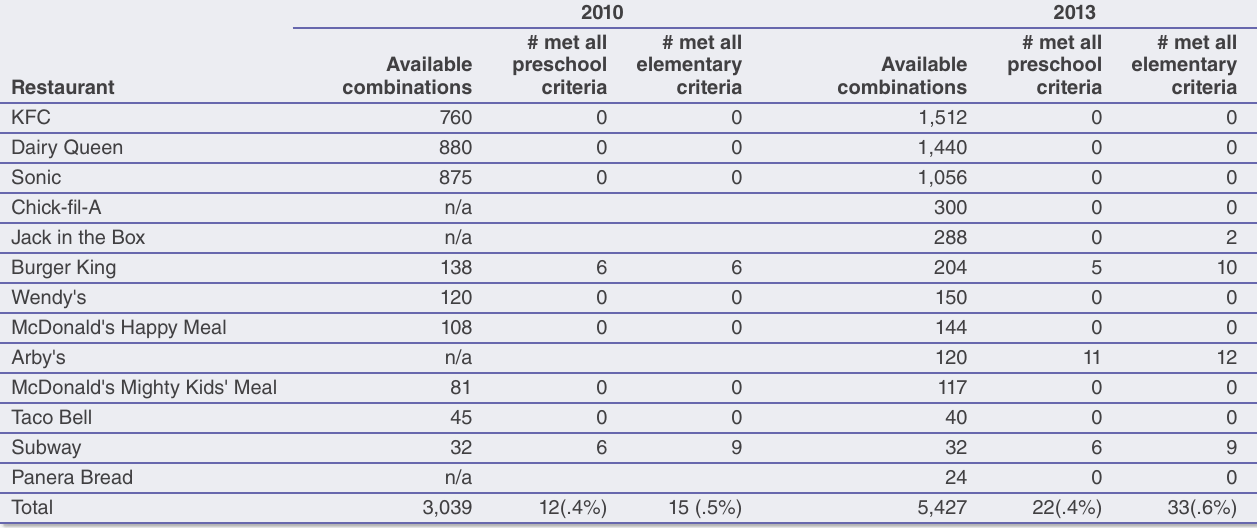
Table 7. Kids’ meal combinations available and the number that met all nutrition criteria